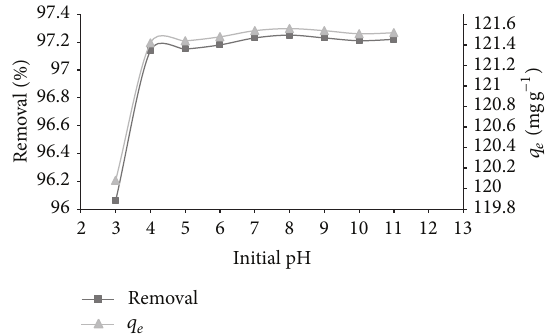
Figure 1: Effect of pH ( 𝐶 𝑜 = 50 mgL −1 , adsorbent dose = 0.4 gL −1 , 𝑡 = 120 min, A . S . = 150 rpm, 𝑇 = 298 K).